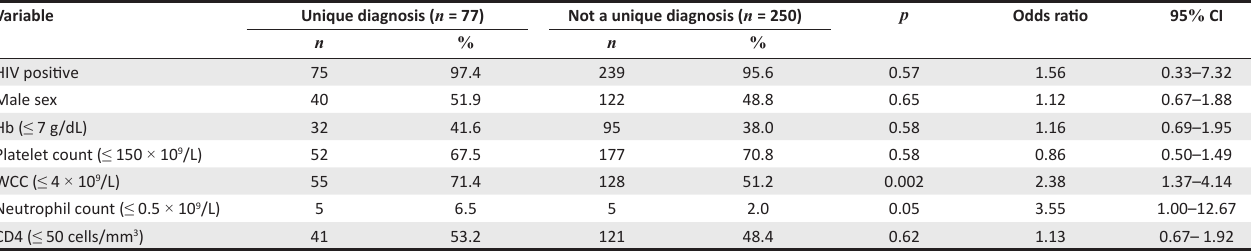
TABLE 3: Predictors of a unique diagnosis on bone marrow examination. Variable Unique diagnosis ( n = 77)